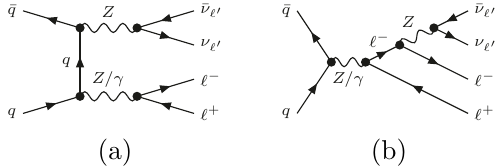
Figure 2 . Sample of Born diagrams contributing to 2 ‘ 2 (cid:23) (cid:12)nal states only in the case of same lepton (cid:13)avour (neutrinos can have (cid:13)avour ‘ 0 = ‘ or ‘ 0 (b) diagrams are